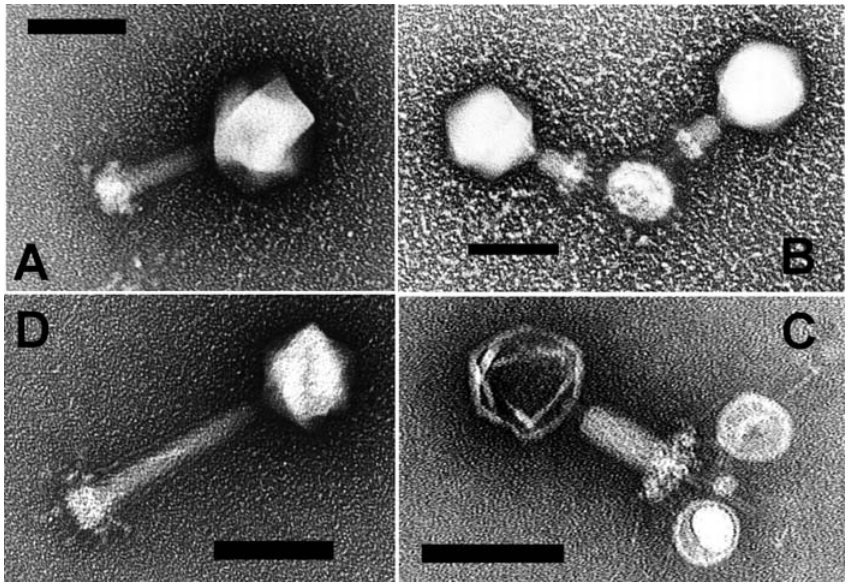
Figure 2. Electron Micrograph of Negative-Stained Prochlorococcus Myoviruses P-SSM2 and P-SSM4 Myovirus P-SSM2 with (A) non-contracted tail and (B) contracted tail, and myovirus P-SSM4 with (C) contracted tail and (D) non-contracted tail. Note the T4-like capsid, baseplate, and tail structure in both myoviruses. Scale bars indicate 100